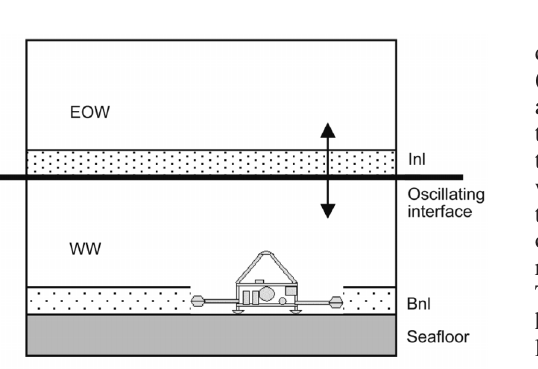
Fig. 8. Sketch of the oscillating water mass inter- face in the BBL. EOW – Eastern Overflow Water; WW – Western Water; bnl – benthic nepheloyd lay- er; inl – intermediate nepheloyd layer. GEOSTAR detected WW for most of the time and events of EOW cascading, as suggested by T / S peaks, lower gas and radiogenic helium contents and lower ra- dionuclide